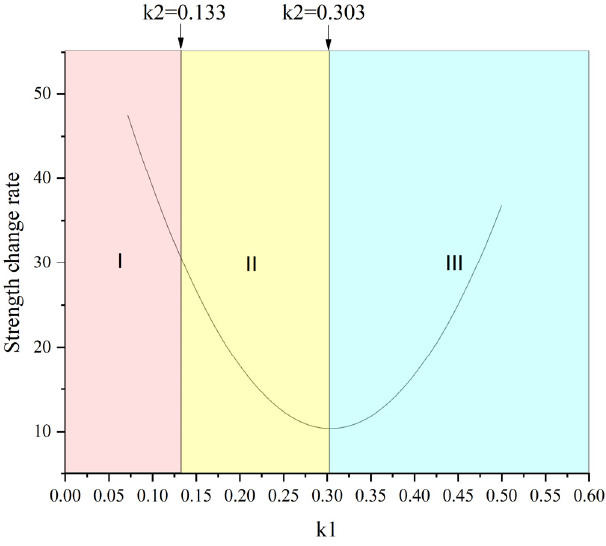
Figure 18. Function graph of Equation (14).